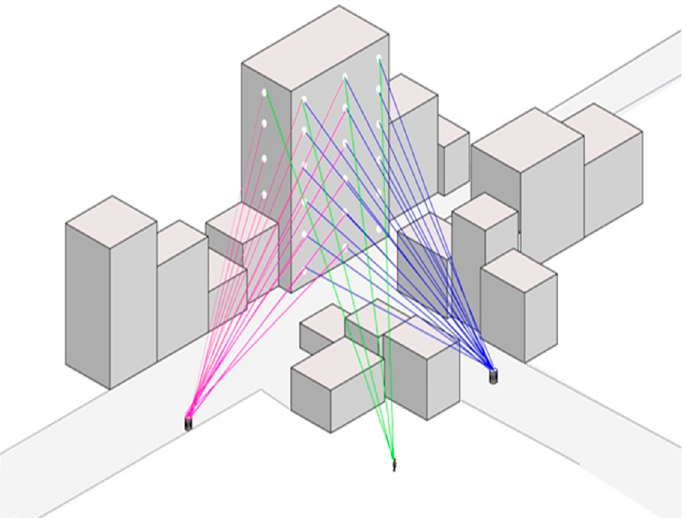
Figure 21. A 3-D image of the fuzzy visibility’s programmed process. To do this, the larger side of tall buildings has 18 points (3 points in 6 rows), and the smaller side has 6 points; 48 points are defined exclusively, and the observer could see 24 points at best.